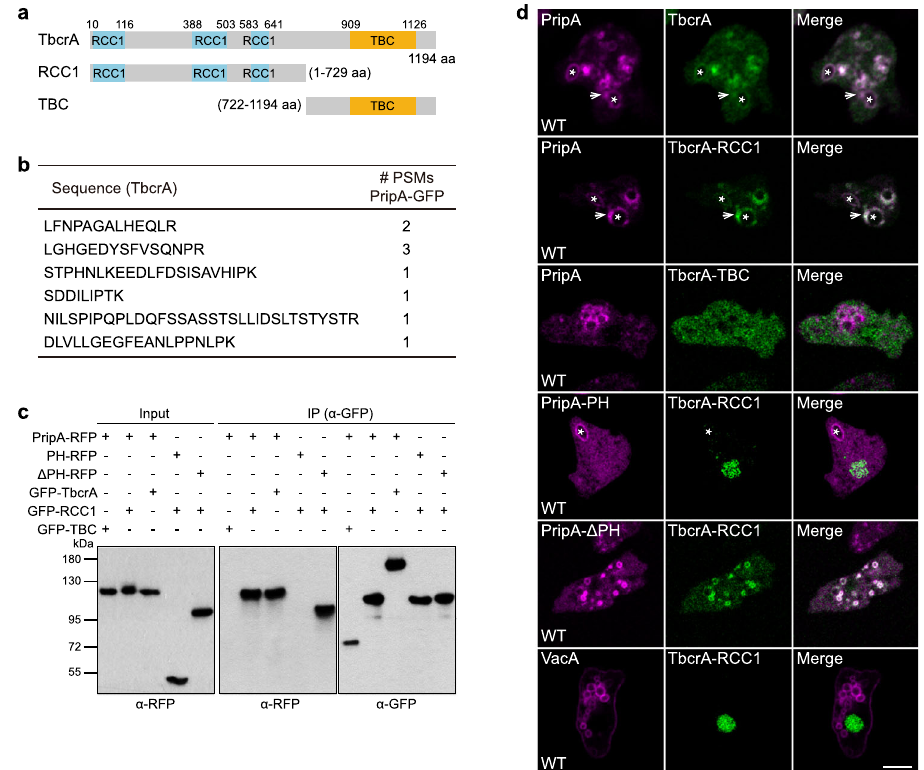
Fig. 6 PripA forms a complex with TbcrA. a Schematic representation of TbcrA, TbcrA-RCC1, and TbcrA-TBC. b Proteomic identi fi cation of TbcrA as a binding partner of PripA. The table shows the identi fi ed unique peptides of TbcrA from PripA-GFP, but not GFP control, pull-down. c Co-immunoprecipitation experiments showing that PripA and PripA- Δ PH speci fi cally pulled down TbcrA and TbcrA-RCC1 from cell lysates. Data was from one representative experiment out of two independent experiments. d Co-expression of RFP-tagged PripA, PripA-PH, PripA- Δ PH, or VacA with GFP-tagged TbcrA, TbcrA- RCC1, or TbcrA-TBC. The Pearson ’ s correlation coef fi cient was 0.94 ± 0.01 for PripA and TbcrA, 0.91 ± 0.03 for PripA and TbcrA-RCC1, 0.24 ± 0.03 for PripA and TbcrA-TBC, 0.33 ± 0.12 for PripA-PH and TbcrA-RCC1, 0.94 ± 0.03 for PripA- Δ PH and TbcrA-RCC1, and 0.09 ± 0.04 for VacA and TbcrA-RCC1. Data represents mean ± SEM ( n = 10 cells). The asterisks mark newly formed macropinosomes and the arrows indicate surrounding vesicles. Scale bar = 5 μ m. Source data for b , c are provided in this